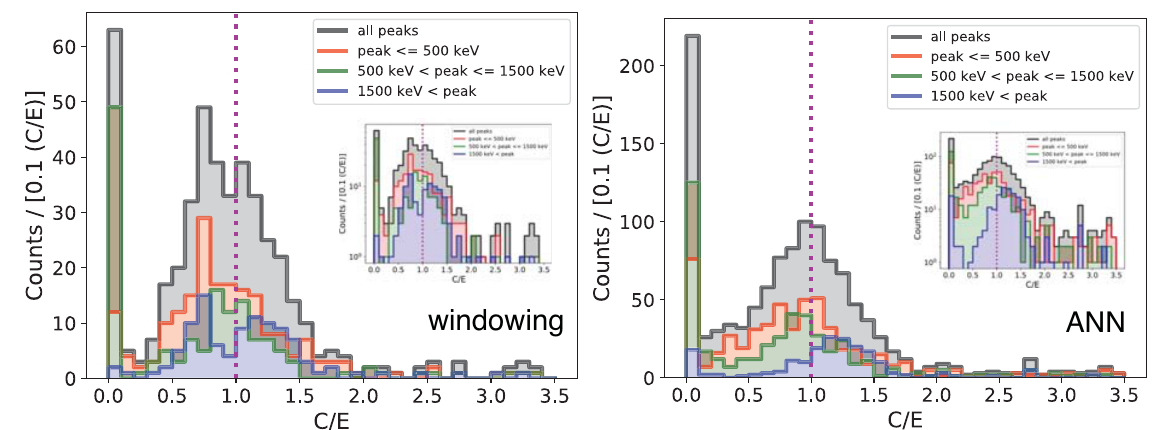
Figure 7: The distribution of FISPACT-II calculated peak values (C) divided by experimental peak values (E) for matched peaks using windowing method (left) and ANN (right) across all valid experiments. Equivalent y-axis log scaled versions of each plot are inserted for